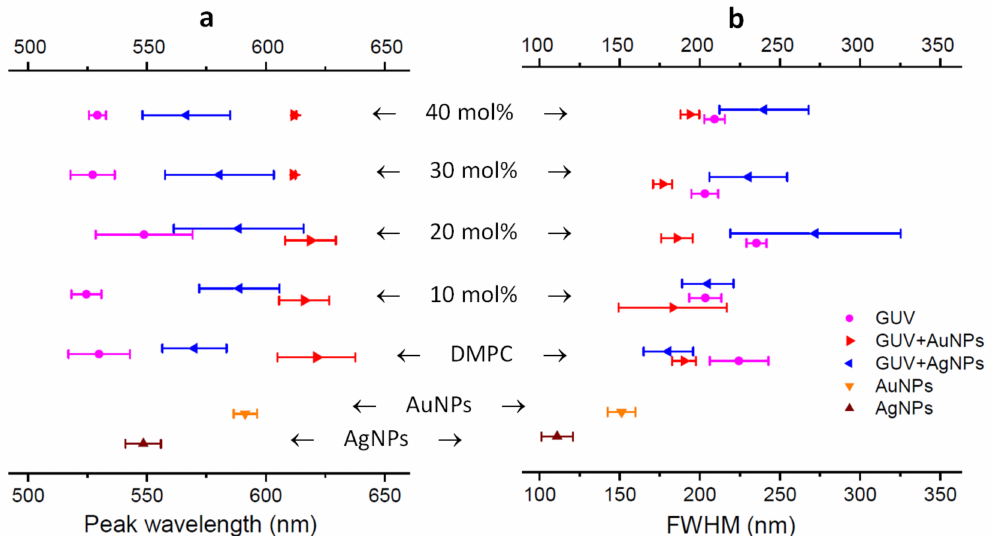
Figure 5. ( a ) The peak wavelengths and ( b ) the FWHM (full width at half maximum) of the spectral profiles from AuNPs alone, AgNPs alone, GUVs alone, GUV+AuNPs, and GUV+AgNPs. The GUV composition was varied from DMPC only to 10, 20, 30 and 40 mol% CHOL:DMPC. The error bars are based on the standard deviations calculated from 15 regions of interest for each